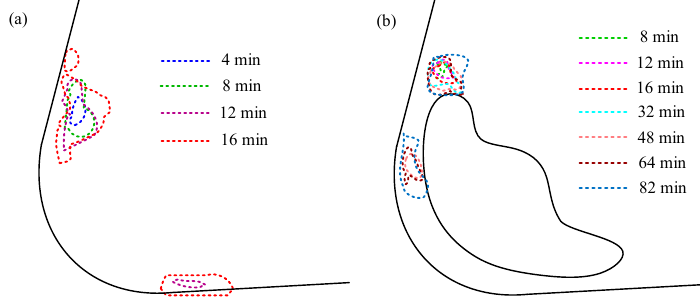
Figure 7. ( a ) The change of crater wear of the rake face of tool A. ( b ) The change of crater wear of the rake face of tool B.